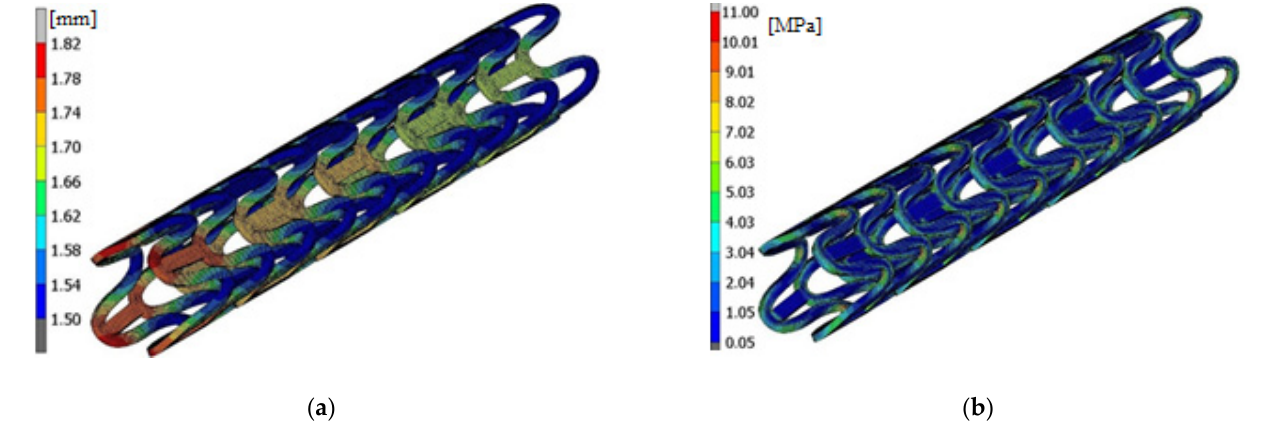
Figure 11. State after the stent crimping: ( a ) the deformation, ( b ) the stress (von Mises).